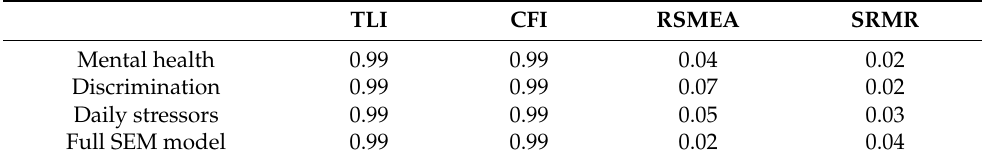
Table 6. Fit indices for the CFA. TLI CFI RSMEA SRMR Mental health